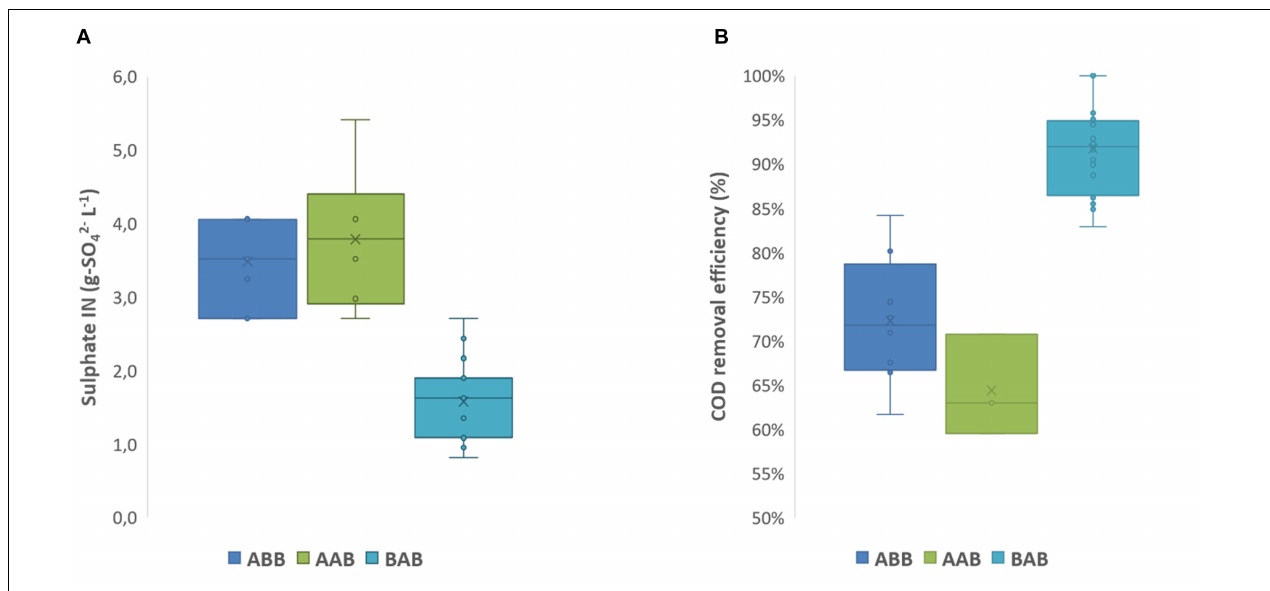
FIGURE 4 | Sulfate concentration of influent wastewater (A) and COD removal efficiency (B) measured in tested operation conditions. ABB condition refers to days 90 to 118, when stationary phase was reached. ABA and AAA conditions are not reported here as not